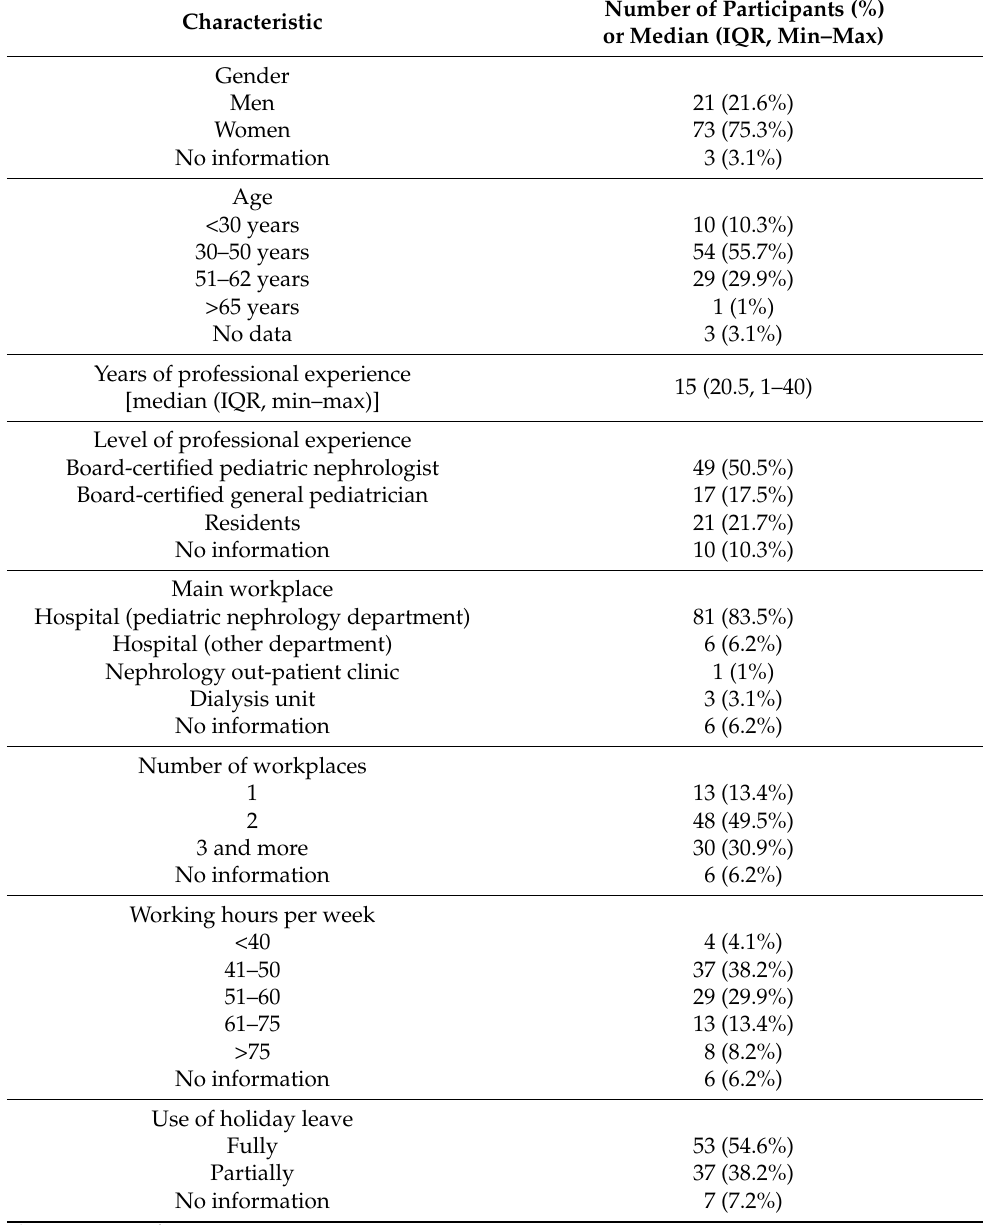
Table 1. The characteristics of the group of pediatric nephrologists in Poland.